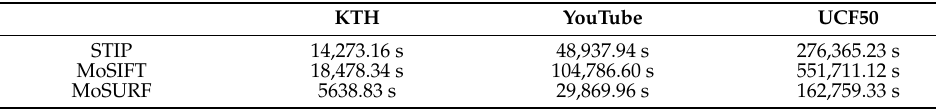
Table 4. Computation times on different